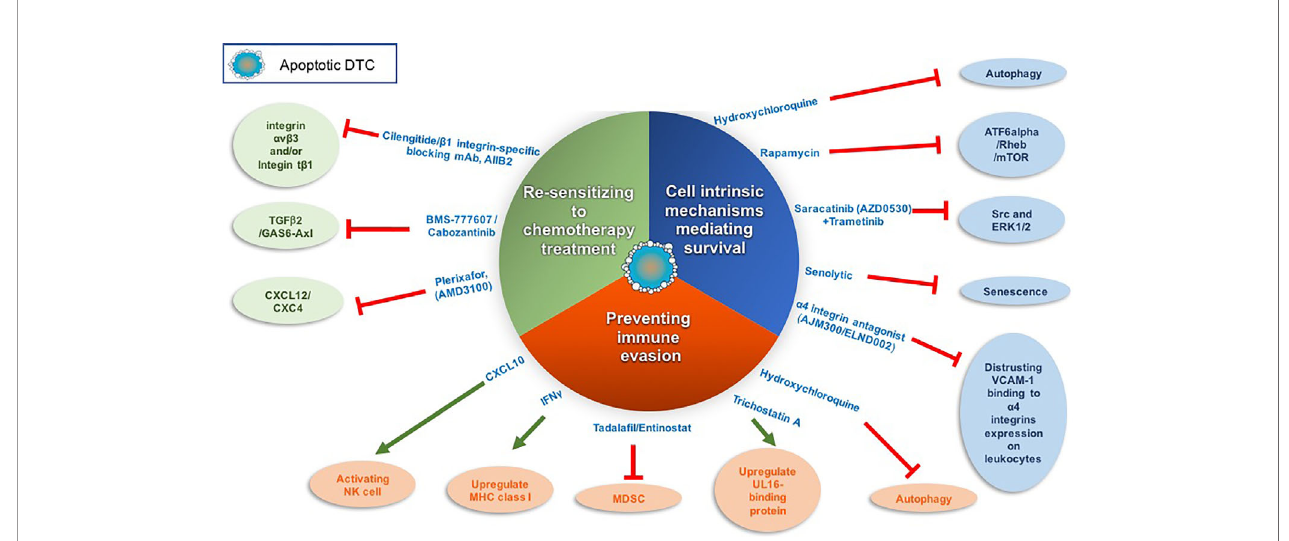
FIGURE 2 | Targeting dormant DTCs for eradication. The following scheme illustrates the different strategies and corresponding drugs that we may utilize to eradicate dormant DTCs. These strategies include inhibiting cell-intrinsic mechanisms of dormant DTCs long-term survival, sensitizing dormant DTCs to chemotherapy treatment and/or preventing dormant DTCs immune evasion. Red line denotes inhibition and green arrow denotes